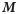
Eigenspectrum analysis of network stability.A Eigenvalue spectrum of the effective connectivity matrix M for the first (blue squares) and second (red dots) iteration. The dashed vertical line marks the edge of stability at a real part of 1. B Contribution ηl (Eq (13)) of an individual eigenprojection l to the shift of the unstable fixed point versus the relative change in indegrees associated with l for the first iteration. The data point corresponding to λc(1) is marked in red. The inset shows the relative angles between δν* and the eigenvectors ul. The red line corresponds to the critical eigendirection. C Entries of the eigenvector uc(1) associated with λc(1) in the populations of the model. The affected areas are 46 and FEF. D Same as C for the second iteration.